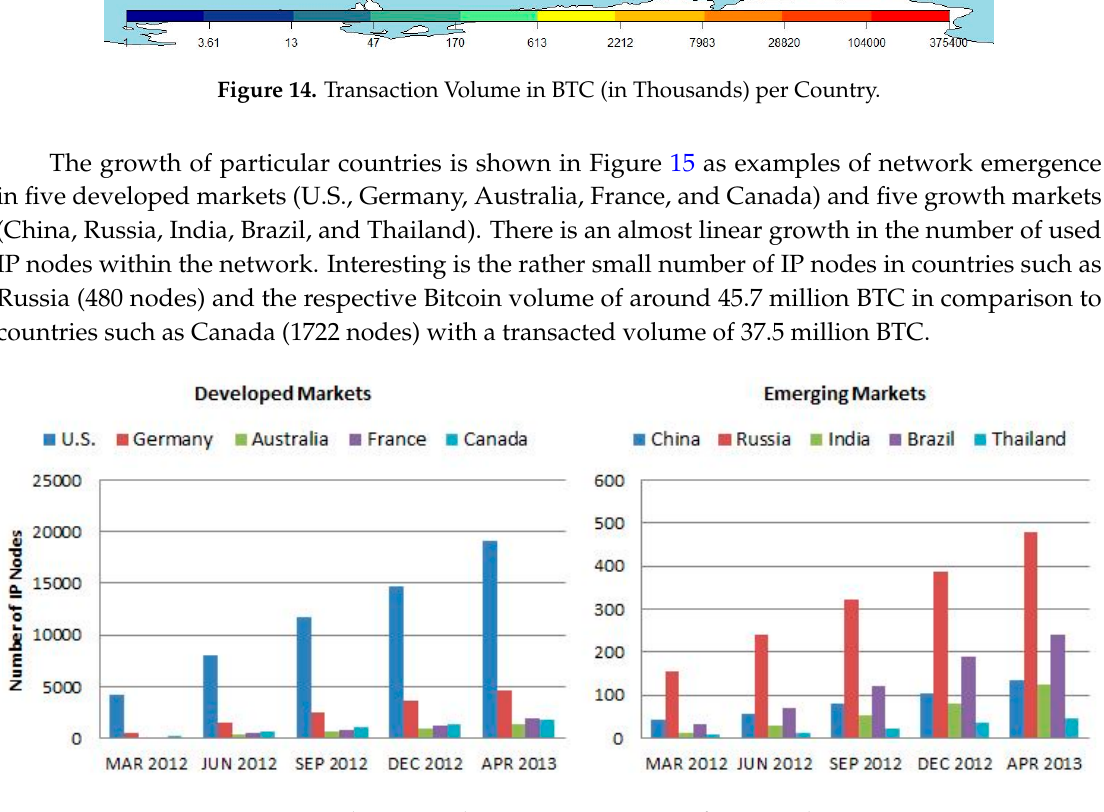
Figure 15. Geographic Network Emergence over Time for Particular Countries.